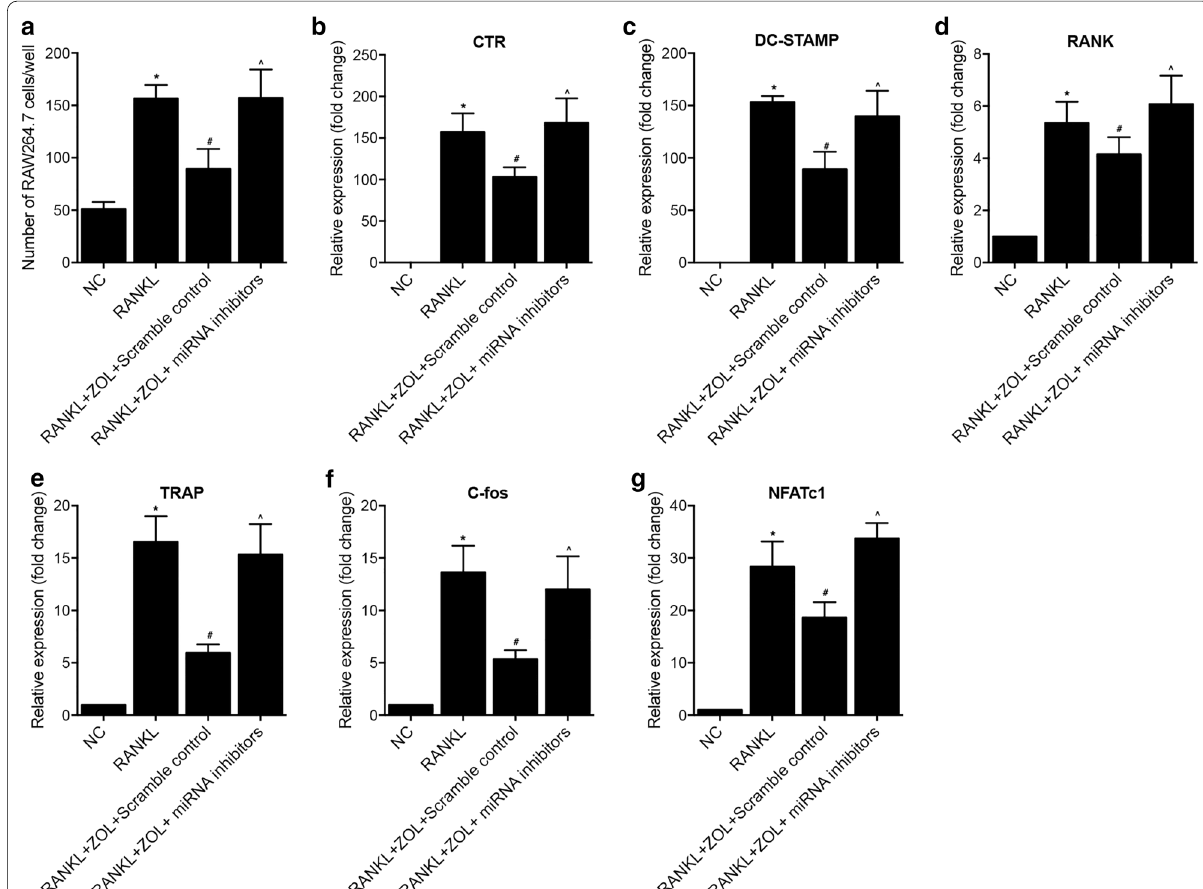
Fig. 6 Quantitative real‑time PCR indicated that the upregulation of the expression of osteoclast‑specific genes induced by RANKL was suppressed by ZOL treatment (*P value < 0.05 vs. NC group; #P value < 0.05 vs. RANKL group; ^P value < 0.05 vs. RANKL ZOL treatment inhibited RANKL‑induced increase in the number of human osteoclast precursor cells, which was obstructed by the knockdown of miR‑302, miR‑101 and miR‑145. b ZOL treatment inhibited RANKL‑induced increase of RNA expression of CTR, which was obstructed by the knockdown of miR‑302, miR‑101 and miR‑145. c ZOL treatment inhibited RANKL‑induced increase of RNA expression of DC‑STAMP, which was obstructed by the knockdown of miR‑302, miR‑101 and miR‑145. d ZOL treatment inhibited RANKL‑induced increase of RNA expression of RANK, which was obstructed by the knockdown of miR‑302, miR‑101 and miR‑145. e ZOL treatment inhibited RANKL‑induced increase of RNA expression of TRAP, which was obstructed by the knockdown of miR‑302, miR‑101 and miR‑145. f ZOL treatment inhibited RANKL‑induced increase of RNA expression of c‑fos, which was obstructed by the knockdown of miR‑302, miR‑101 and miR‑145. g ZOL treatment inhibited RANKL‑induced increase of RNA expression of NFATc1, which was obstructed by the knockdown of miR‑302, miR‑101 and